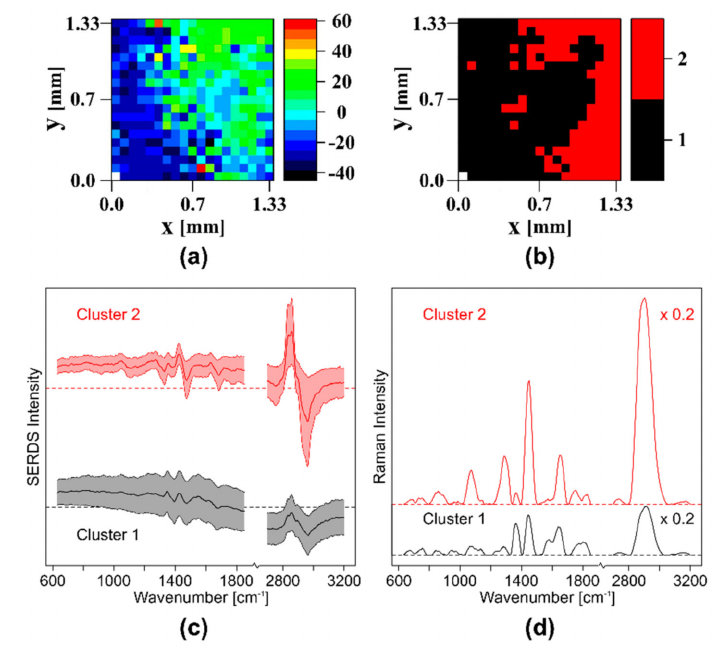
Figure 8. SERDS imaging of a piece of pork meat with protein and lipid-rich areas: ( a ) intensity map of the SERDS spectra at 2900 cm − 1 ; ( b ) cluster map of the SERDS spectra; ( c ) clustered normalized, mean SERDS spectra and their standard deviation; ( d ) reconstructed and baseline corrected mean Raman spectra of the two clusters shown in ( c ). The high wavenumber regions were multiplied by 0.2 for better